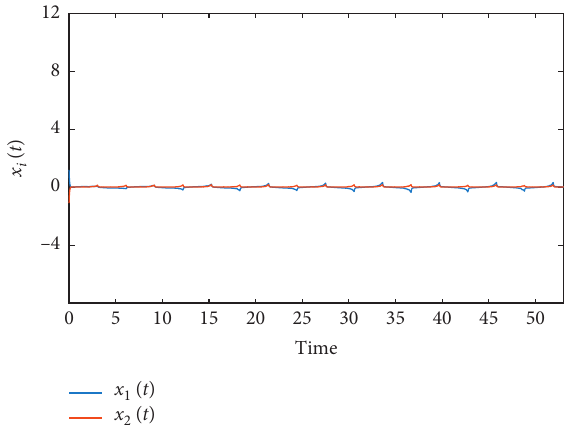
Figure 5: State trajectories x observer-based E-APIC.